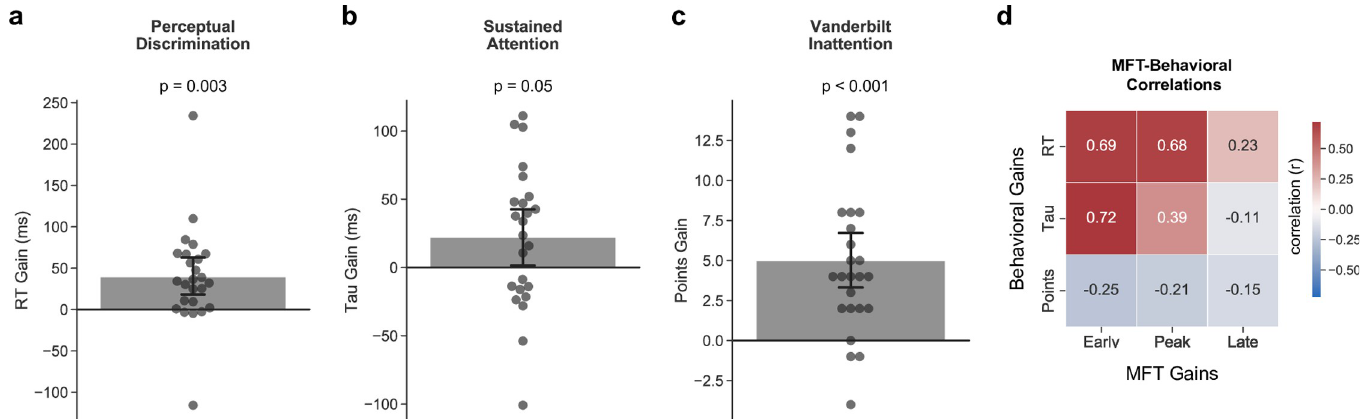
Fig 3. Changes in exploratory outcome metrics: Behavioral and parent-report measures of attention. Intervention-related changes in objective behavioral and parent- report measures of attention, specifically a response time (RT) on the perceptual discrimination task, b tau on the sustained attention task, and c points on the Vanderbilt inattention subscale (parent-report). Data are presented as mean ± 95% bootstrapped confidence intervals (1000 bootstrap iterations), and circles represent individual participants. d Pearson correlations between midline frontal theta (MFT) improvements at each composite window and the behavioral and parent-report improvements.